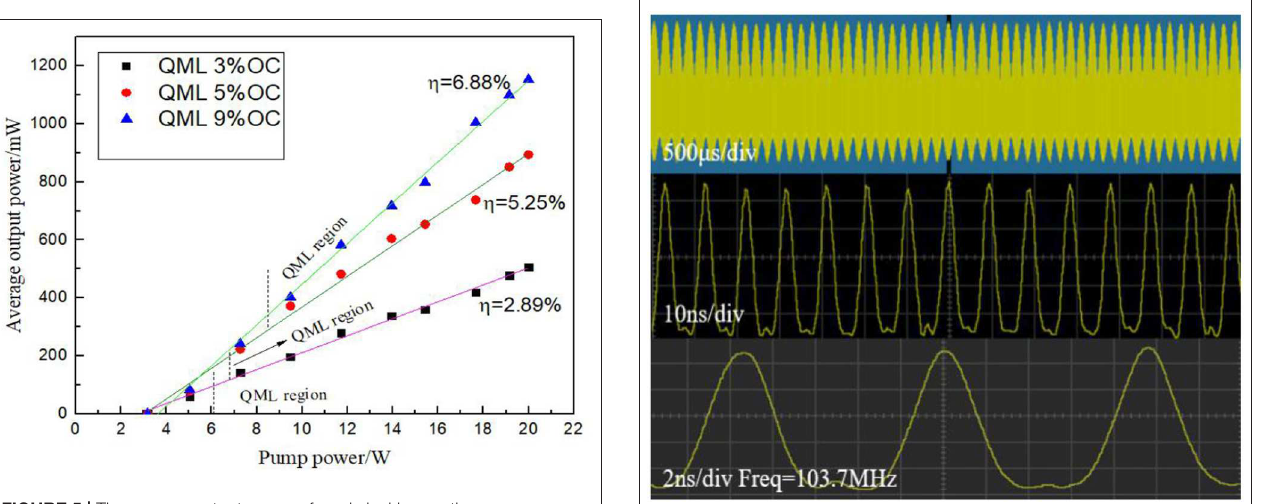
FIGURE 5 | The average output power of mode locking vs. the pump power.